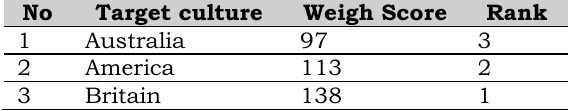
Table 1. Students’ preference for target